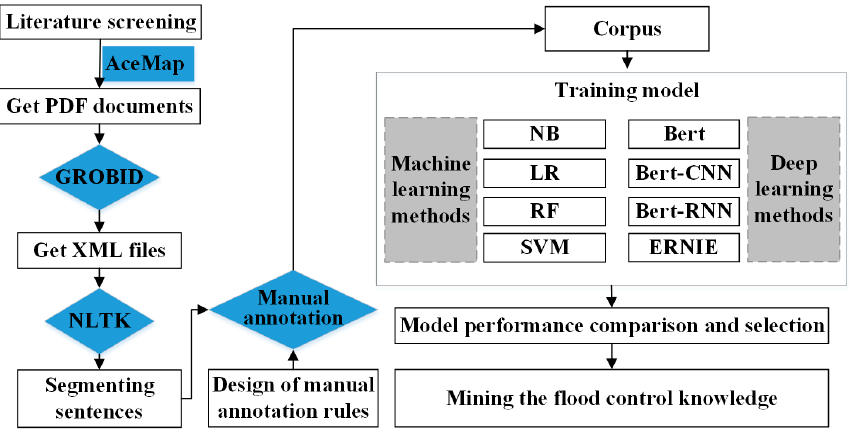
Figure 1. Technical roadmap.